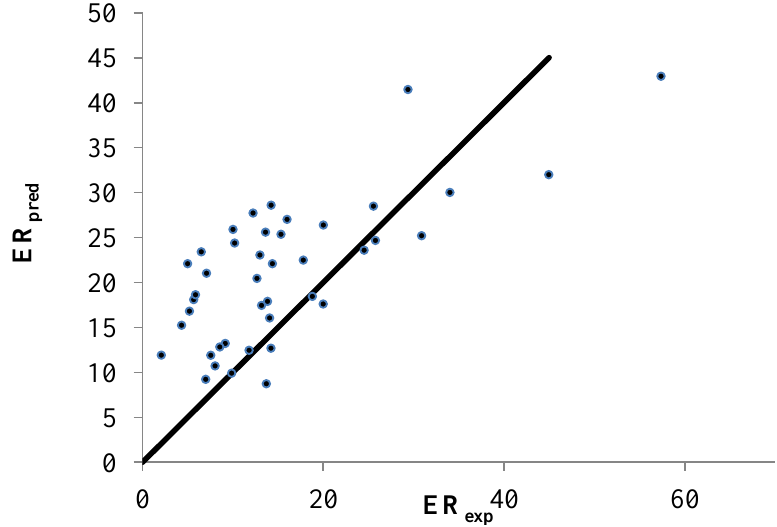
Figure 4. Correlation between the linear predicted and experimental ER for the set of 42 nonpolar CPEs from DB #3. The enhanced replacement method (ERM) was applied for the selection of the